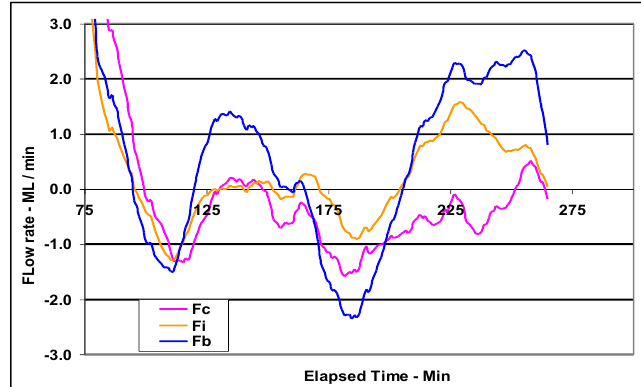
Fig. 12: Compartment fluid transfer rates during